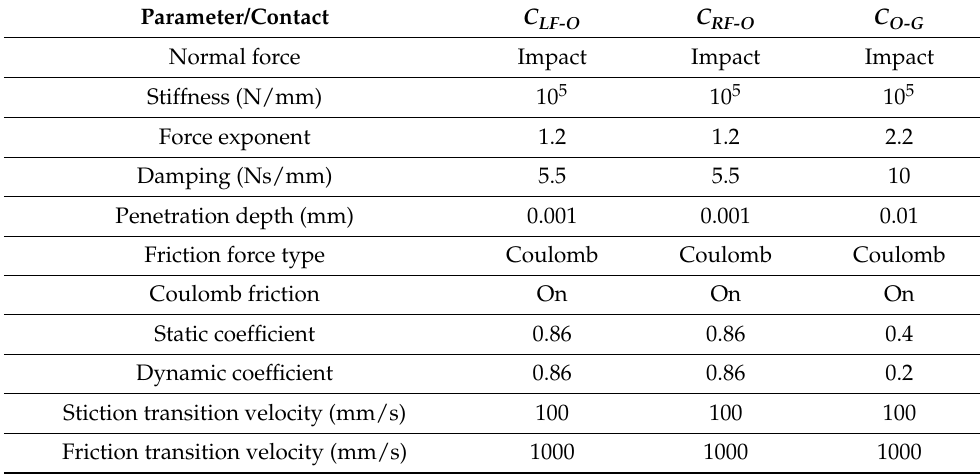
Table 1. Model contact parameters. Source: own.